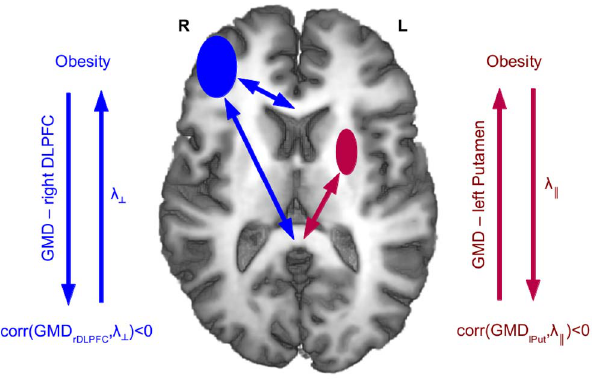
Figure 3. Schematic summary of correlation between diffusion parameters in the corpus callosum and GMD values in the left putamen and right DLPFC (see also Figures 1 and 2). GMD rDLPFC was negatively correlated with l H ; in genu and splenium of the corpus callosum (blue arrows), while the GMD lPut was negatively correlated with l ||; in the body and splenium (red arrows). Thus, an obesity-related reduction of GMD in the right DLPFC was associated with an increase of l H ; in the entire corpus callosum, while an obesity-related increase of GMD in the left putamen was associated with a decrease of l ||; in the body and splenium of the corpus callosum.